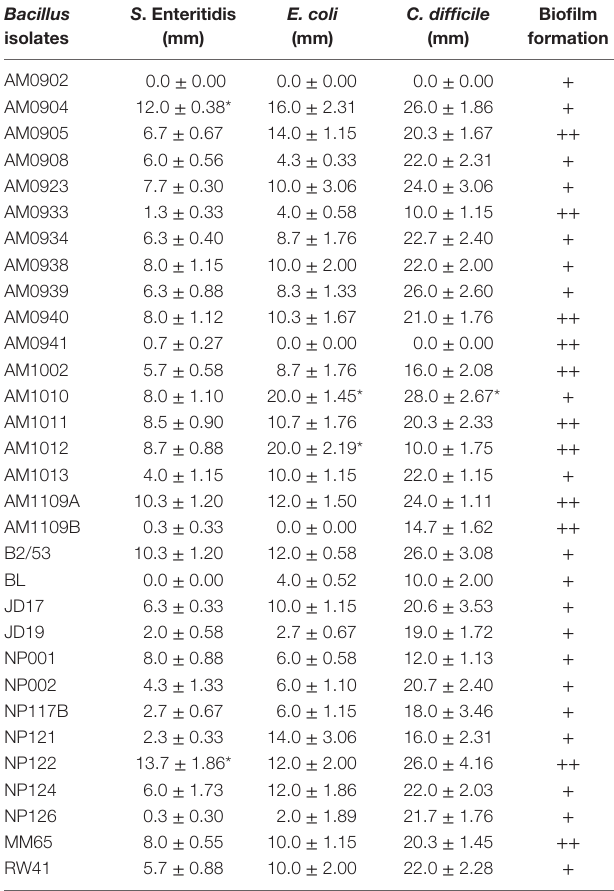
TaBle 2 | evaluation of antimicrobial activity a and biofilm synthesis b of different Bacillus spp. isolates.